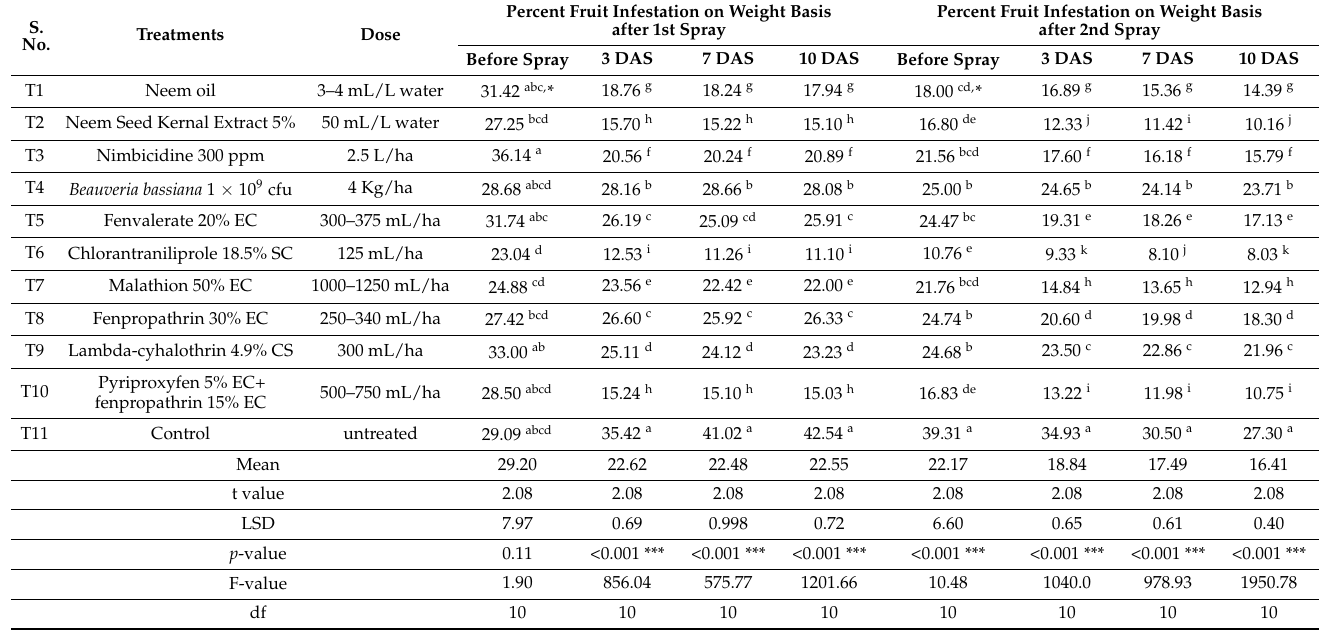
Table 3. Efficacy of 10 recommended insecticides against okra fruit and shoot borer ( Earias spp.) as compared to a no insecticidal control in regard to the percent fruit infestation on a weight basis following the application of two insecticidal spray